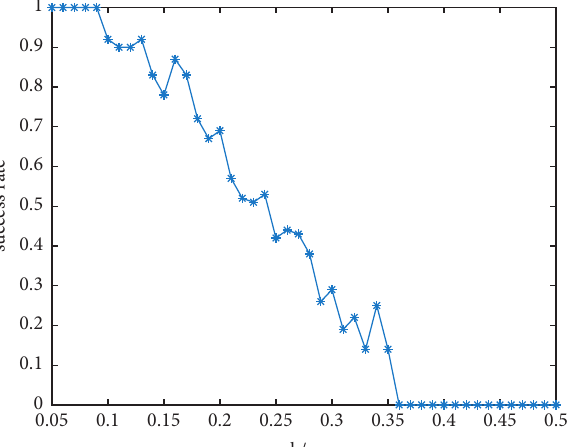
Figure 4: Success rates for the proposed algorithm with fixed m and the length of the unknown